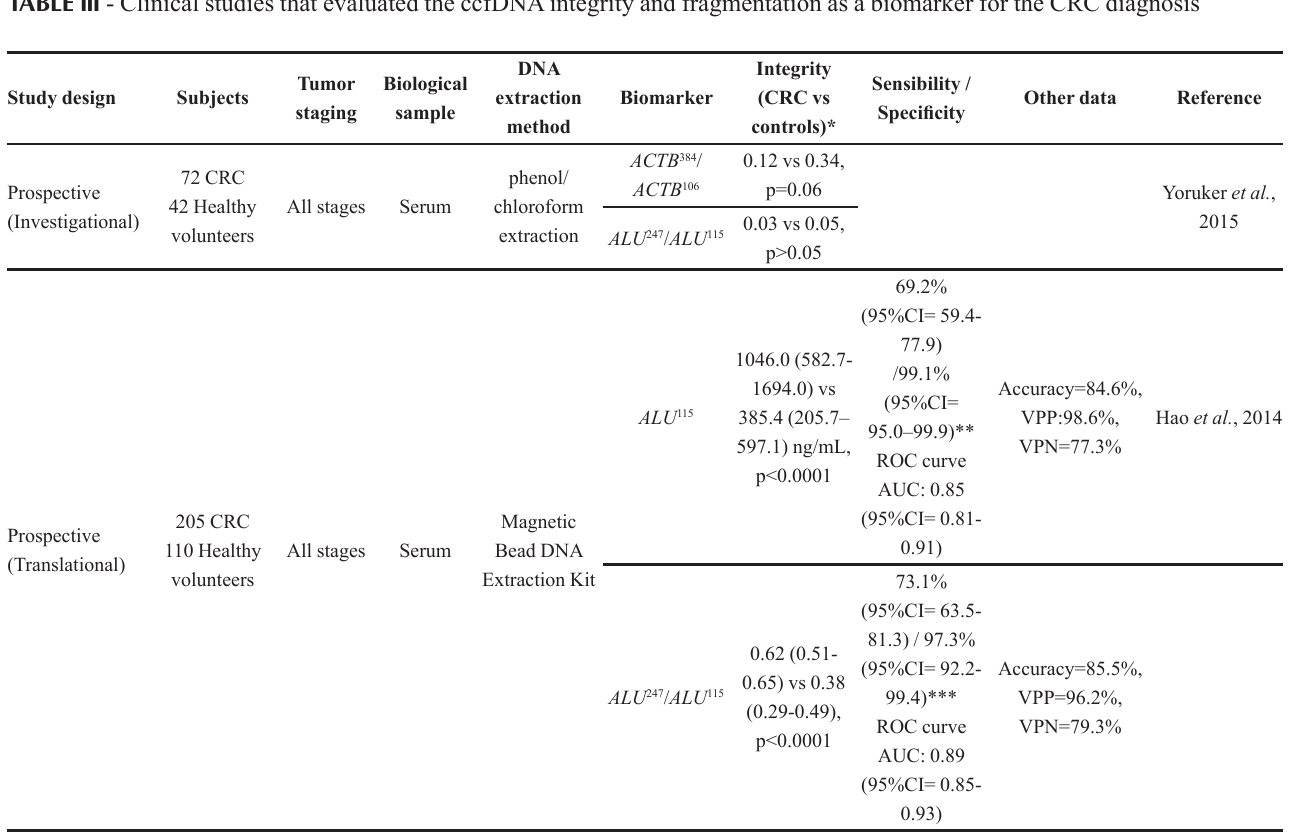
TABLE III - Clinical studies that evaluated the ccfDNA integrity and fragmentation as a biomarker for the CRC